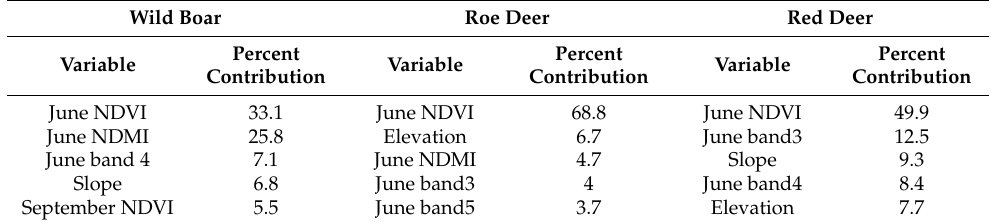
Table 5. Percent contribution of environmental